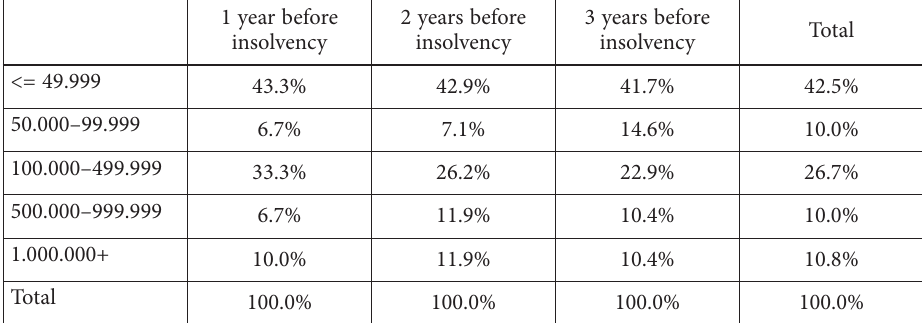
Table 1. Sample structure – company’s size (measured by annual sales in mil. CZK) (source: author based on Bisnode